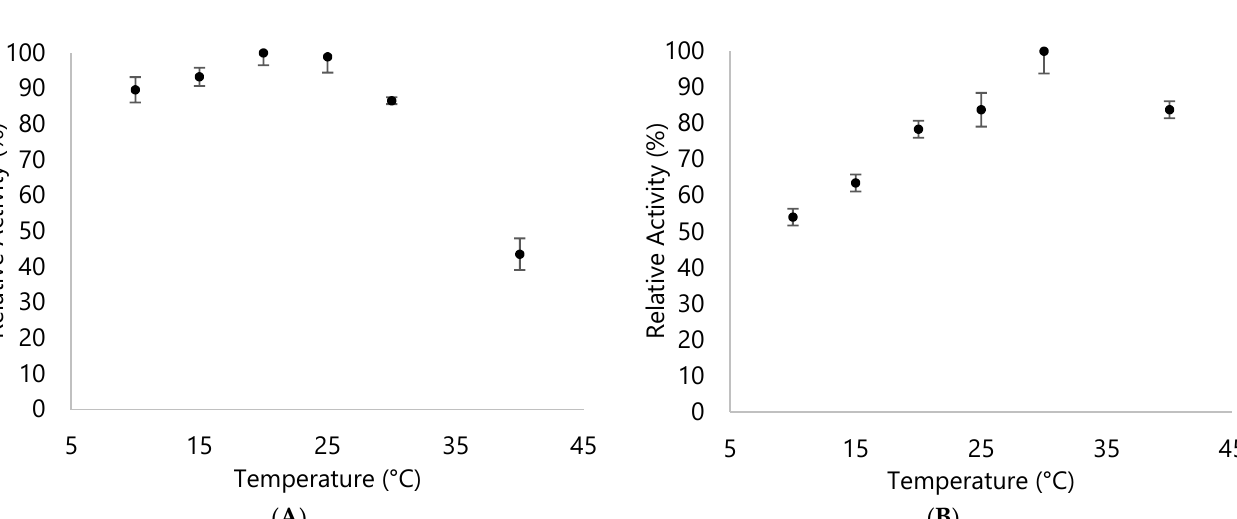
Figure 7. Relative activity of ( A ) DypA and ( B ) DypB with 144 µM RB5 assay in 25 mM citrate buffer (pH 3.6) at different temperatures.